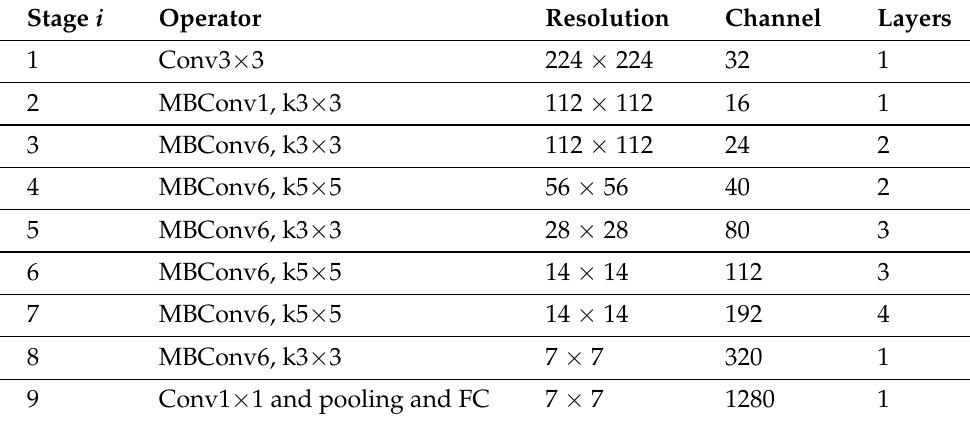
Table 2. Baseline network: